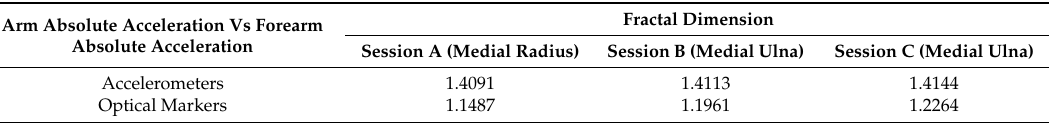
Figure 9. From the left, the absolute accelerations a acc and a mrk of the arm with respect to the forearm, for all the acquisitions: blue for Acquisition A, red for B, and yellow for C. Table 2. Fractal dimension of the combined acceleration signals arm versus forearm for the two measurement systems, for the three acquisitions.